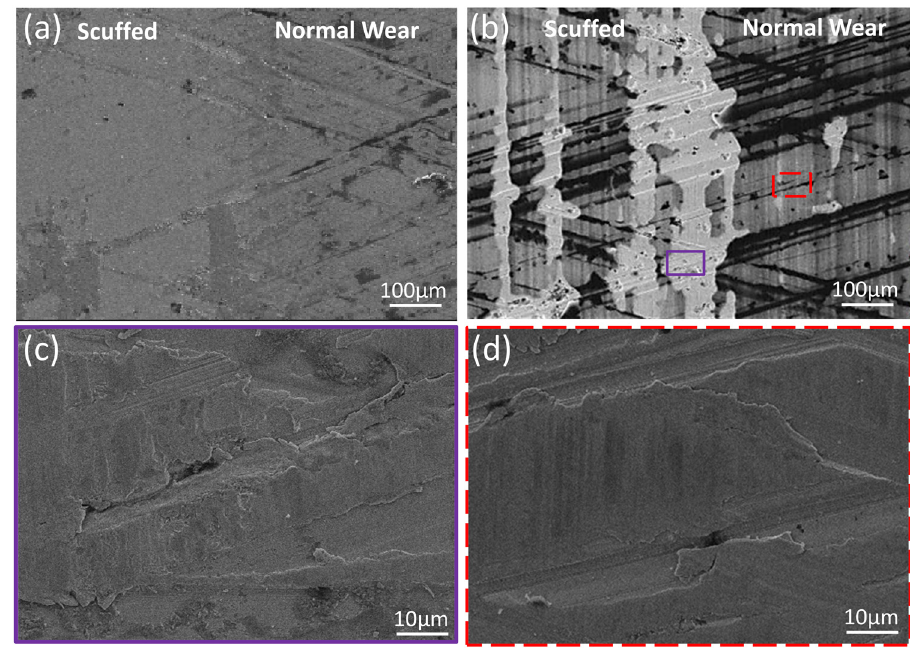
Figure 11: The SEM images of the nitriding cylinder liner surface after scu ffi ng test: ( a ) base oil lubricated, ( b ) 2 wt% PANi/ND lubricated, ( c ) the typical scu ff ed area in ( b ) and ( d ) the typical normal wear area in ( b )